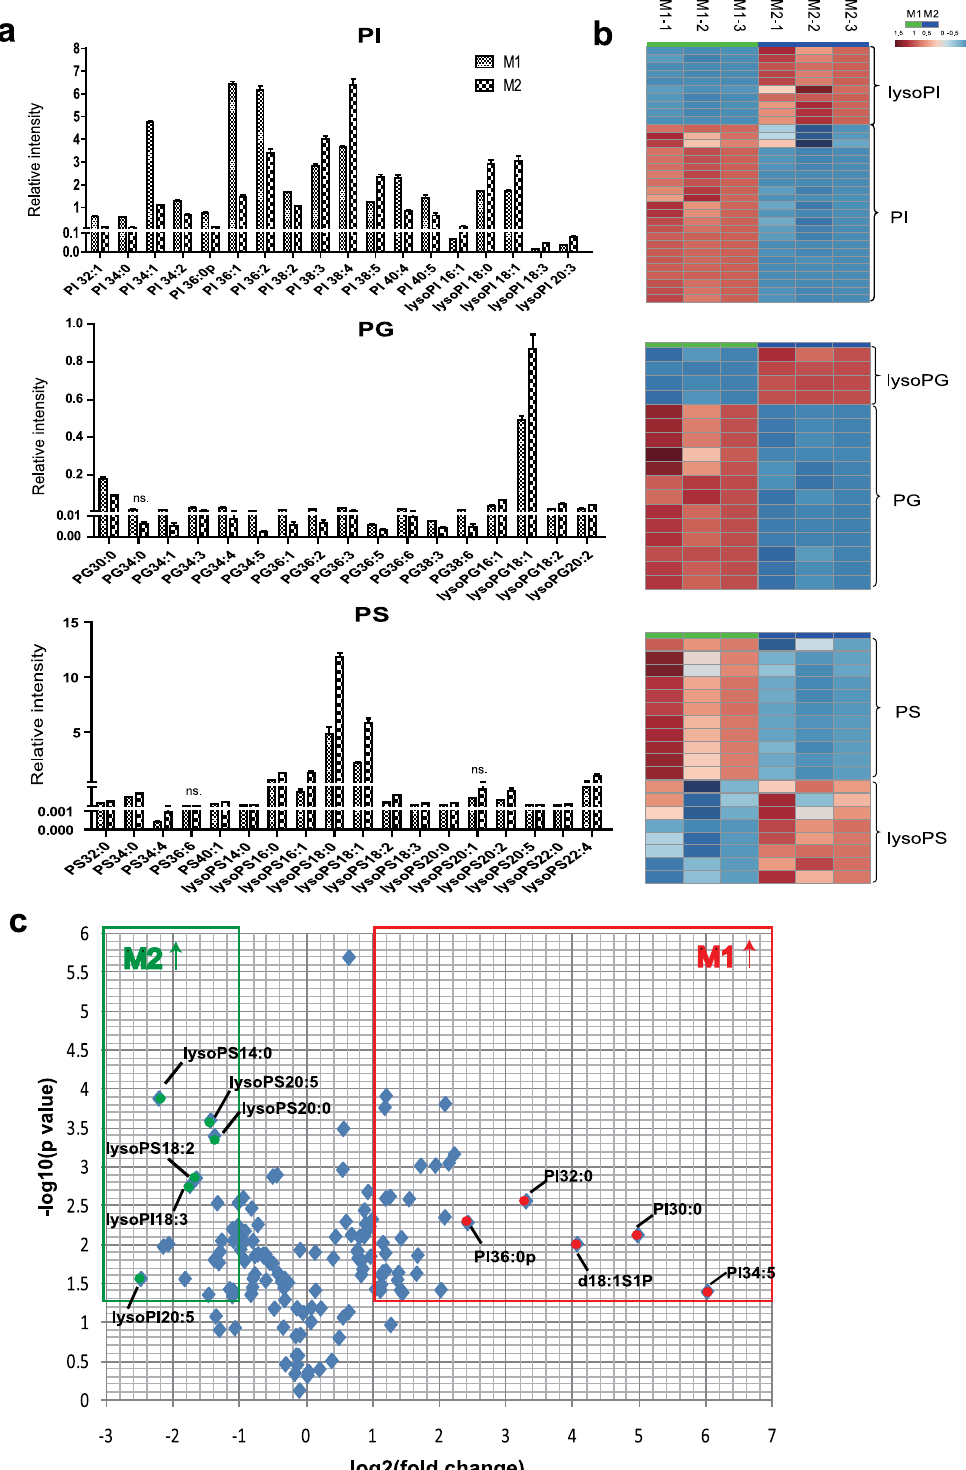
Figure 5. Mouse M2 macrophages have higher levels of lysophospholipids than do M1 macrophages. ( a,b ) As shown in the histogram and heatmap, lysophospholipids, including lysoPI, lysoPG, and lysoPS, were increased in M2 macrophages, whereas PI, PG, and PS were increased in M1 macrophages. ( c ) Volcano plots show that lipids were differentially expressed between M1 and M2 macrophages. The x-axis shows the log2-fold change (fold change = intensity of M1 to M2). The y-axis shows the-log10 p-value for the corresponding lipids. The top lipids that are elevated in M1 cells are highlighted in red, and those that are elevated in M2 cells are indicated by green dots (fold change > 1.5 or < 0.67, p <